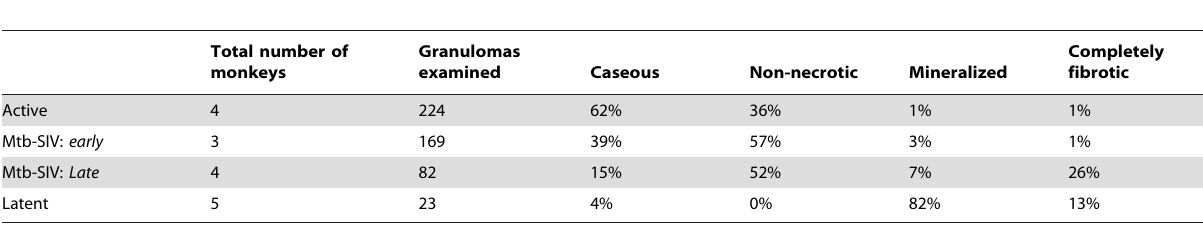
Table 2. Granulomas observed in Mtb-only and SIV-Mtb co-infected